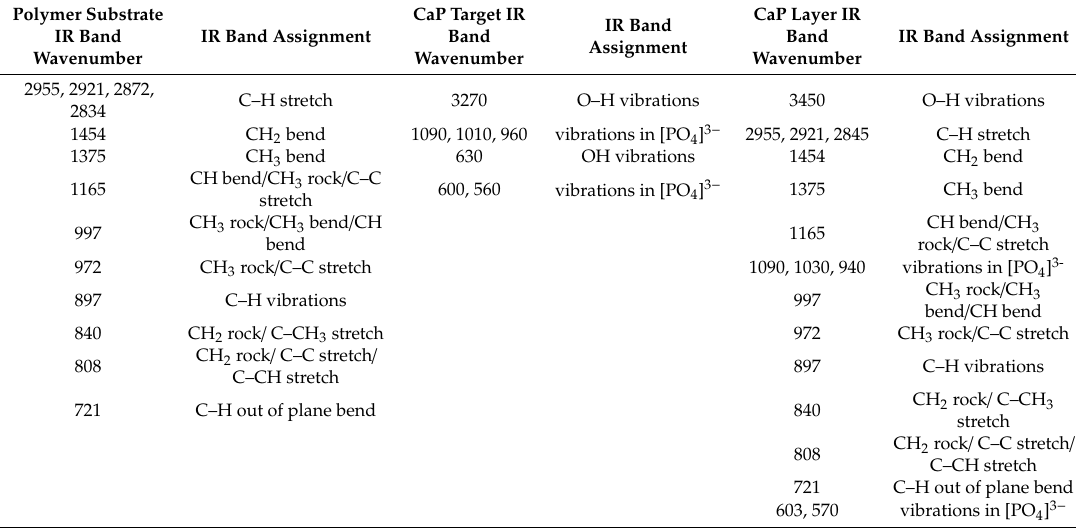
Table 1. IR band assignment of polypropylene substrate [24], CaP sputtering target [25], and CaP coatings [12–14] on polymer